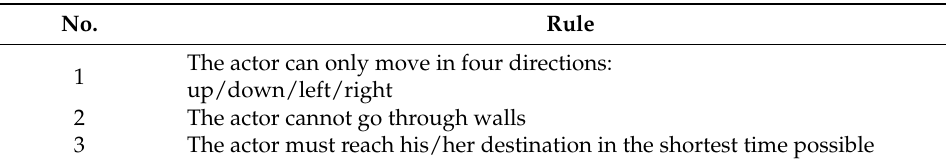
Table 1. Basic rules of the maze game.